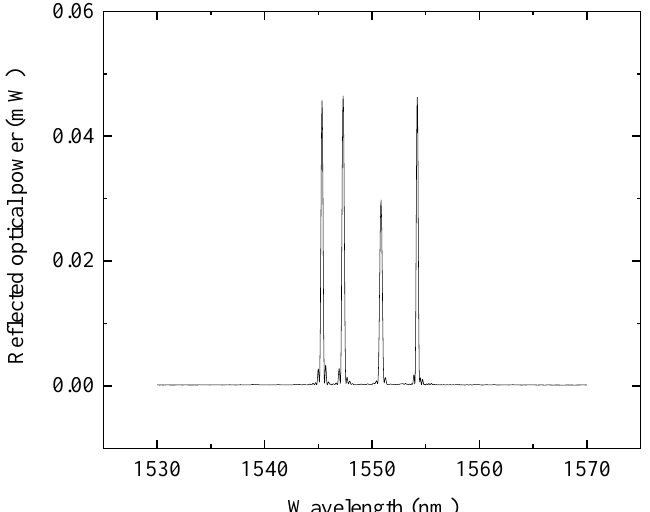
Figure 2. Reflection spectrum of the accelerometer output, being observed the reflection spectra for the four